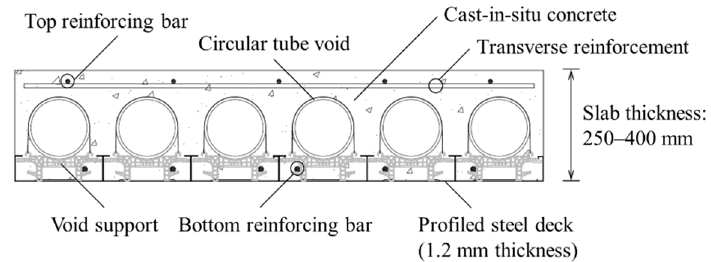
Figure 1. Typical cross-section configuration of a TUBEDECK (TD) slab.